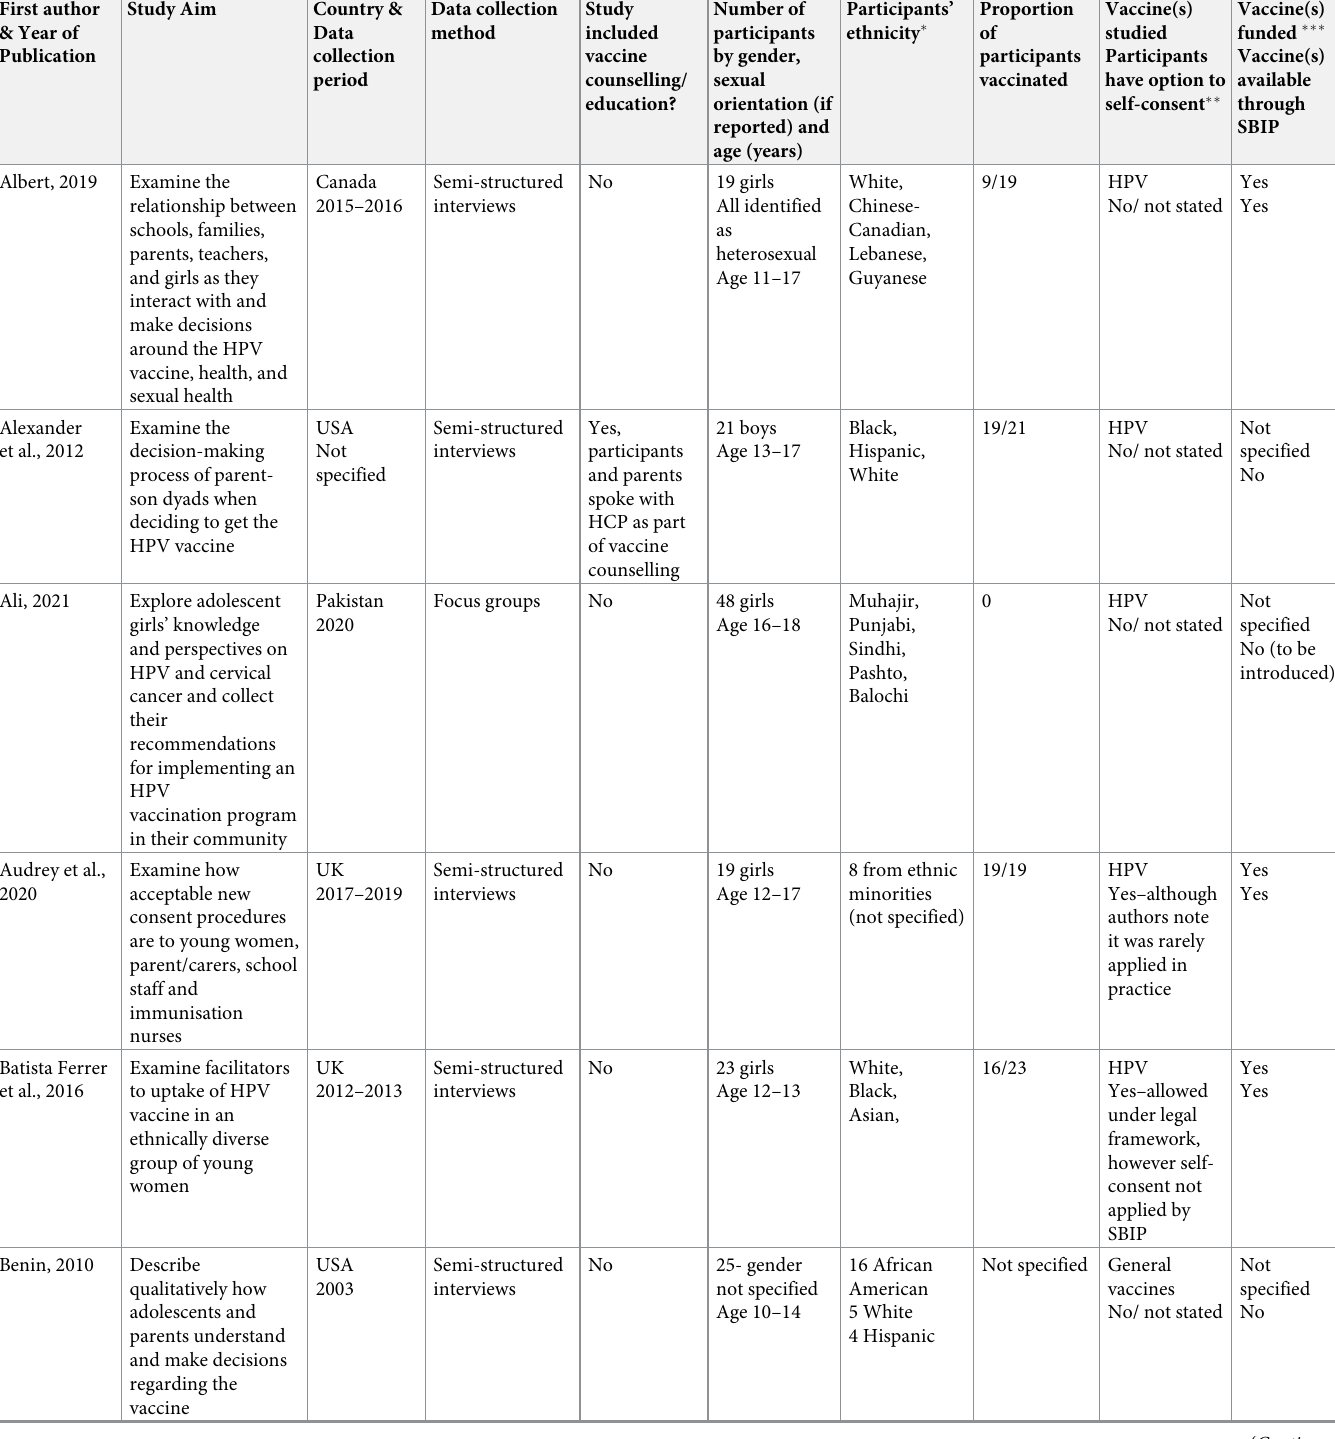
Table 1. Characteristics of included